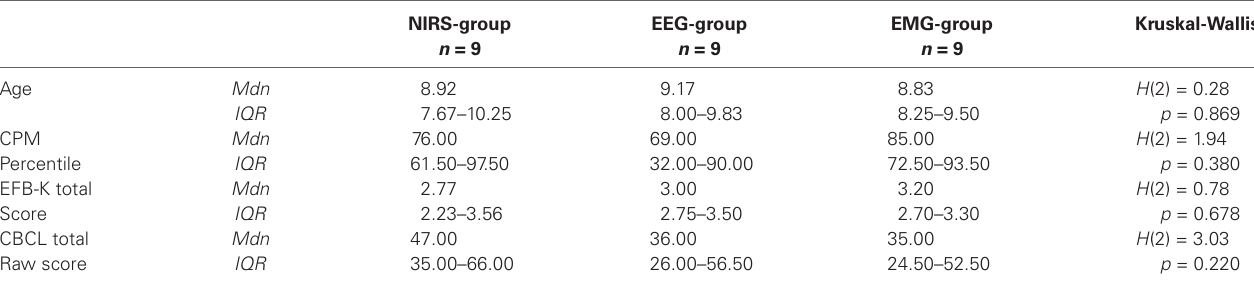
Table 1 | Description of the sample